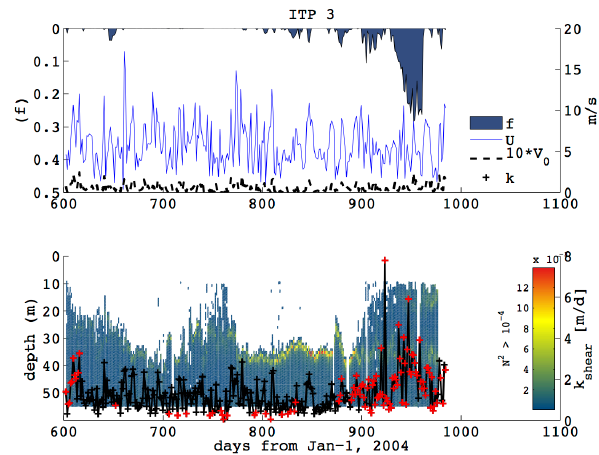
1 Figure 4. Modified from Frew et al., (2007), the relationship between the 10-m wind speed and 2 Fig. 4. Modified from Frew et al. (2007), the relationship between the mean-squared wave slope has been represented in this study by a cubic (solid black line). 3 the 10m wind speed and the mean-squared wave slope has been represented in this study as cubic (solid black line).